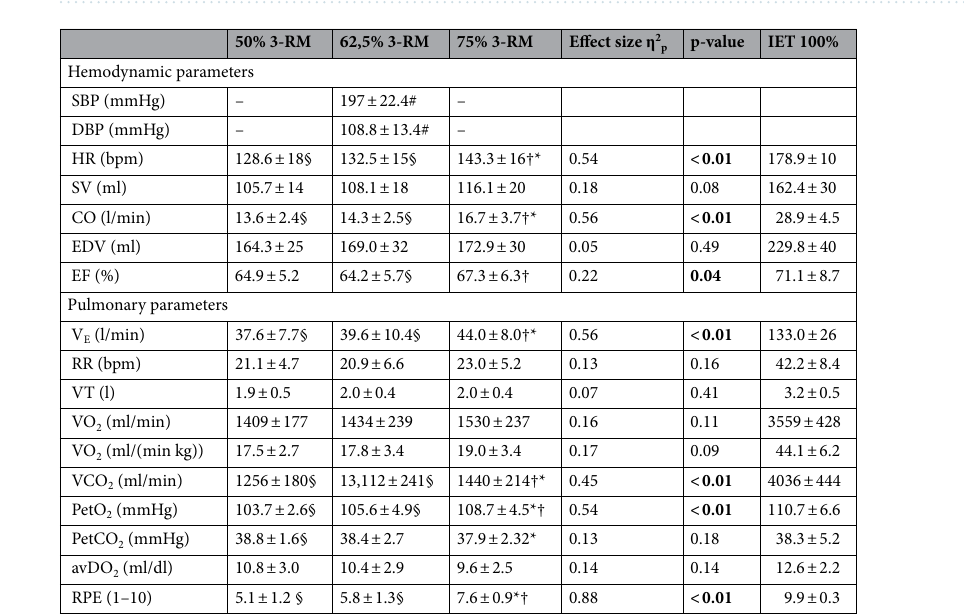
Figure 1. shows the timeline of measurements ( A ) execution and equipment ( B ). ( A ) The three load conditions (3 sets of 10 repetitions interspaced by a resting period of 4 min; intensities: 50%, 62.5% and 75% of 3-RM) were performed on separate days with a break lasting at least 5 days to ensure adequate recovery. The order of sessions 2 and 3 was randomized. On the first day, the individual 3-repetition maximum (3 RM) in the smith-machine back squat was determined. ( B ) Resting and post-exercise period = upright in a smith machine; exercise periods = ten repetitions within 60 s; Execution = 2 s descend, 2 s ascend and 2 s hold at the top; Ventilation and hemodynamic were recorded continuously; blood pressure measurement (only in post-exercise period): immediately after exercise, 1:30 min after exercise, and 2:30 after exercise; Blood pressure measurements during strength training sessions were not taken during the standardized strength training sessions because of interference in the repetition sequence and for safety reasons.